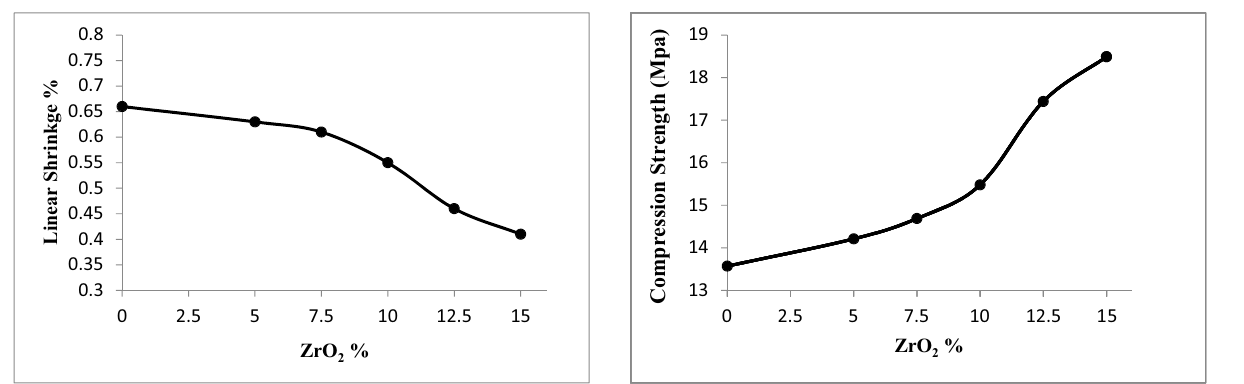
Figure 7: Compressive strength for various ZrO 2 additions in refractory